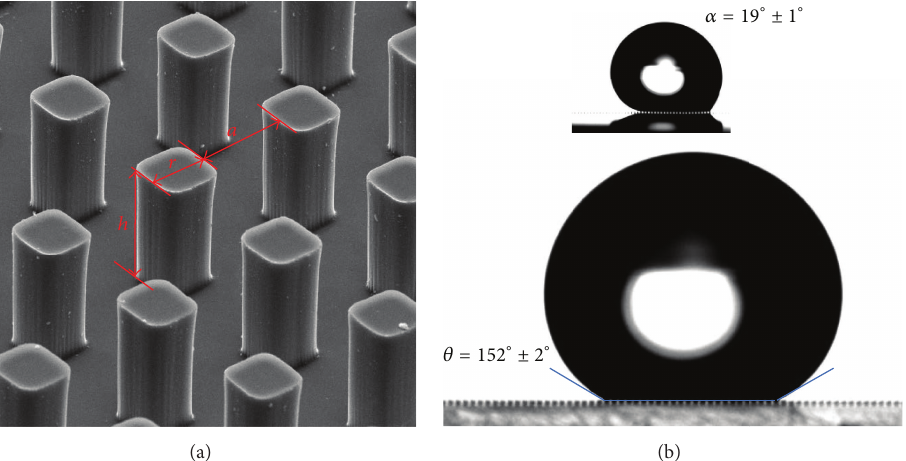
Figure 1: (a) SEM image ( 𝑎 is the pillar spacing, ℎ is the height of the pillars, and 𝑟 is the width) and (b) wetting properties of micropillared